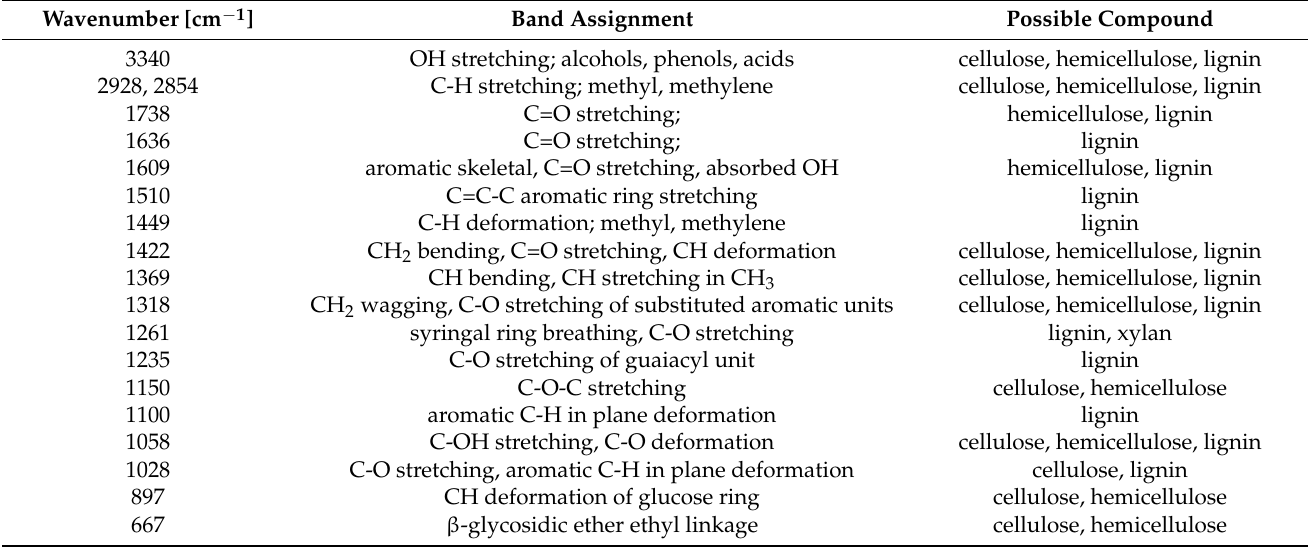
Figure 2. Peanut shell powder analysis. ( a ) FT-IR spectrum of the PSP; ( b ) thermal decomposition of the PSP. Table 2. Characteristic FT-IR bands of peanut shell